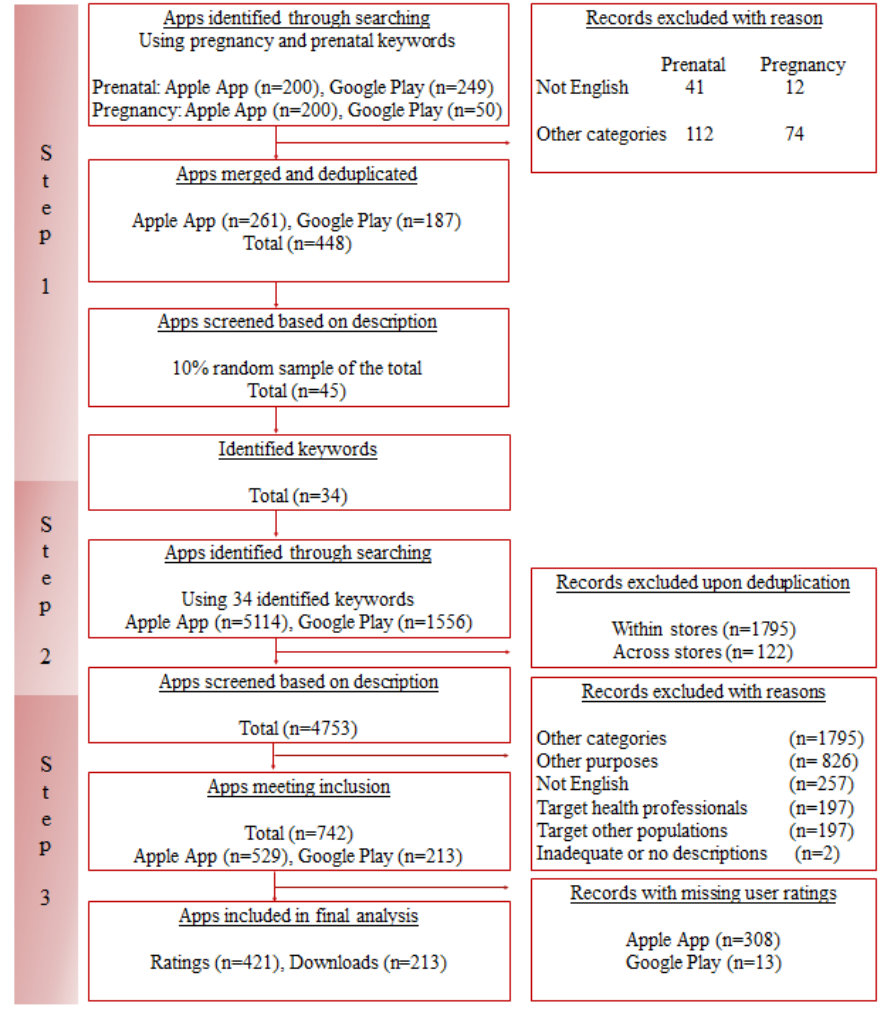
Figure 1. Flowchart detailing the sample selection